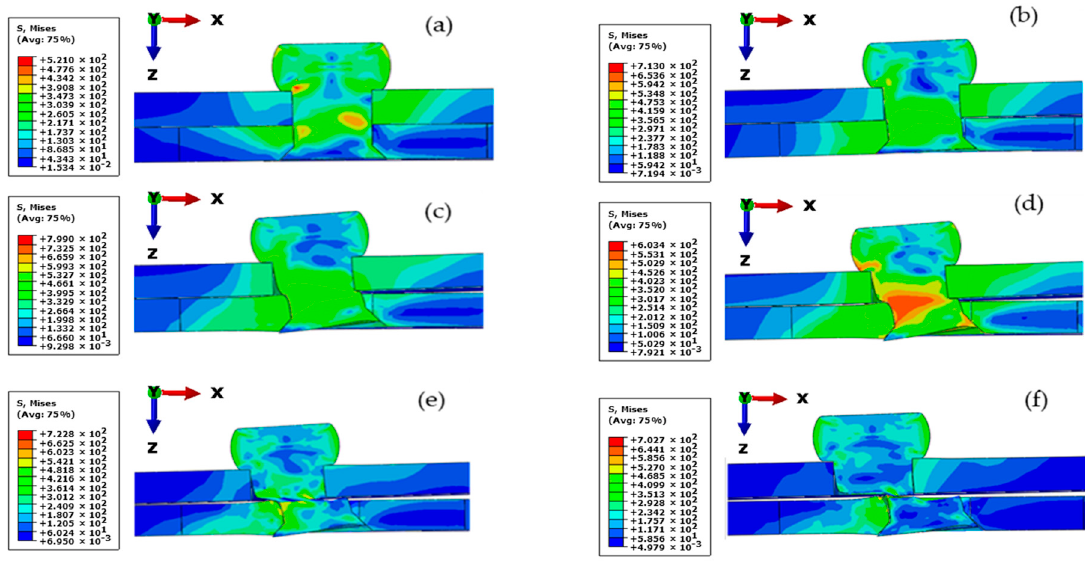
Figure 18. Shear failure process of rivet. (Unit: MPa). ( a ) Riveting completed. ( b ) Shear starting. ( c ) Deformation of rivet. ( d ) Significant stress concentration. ( e ) Rivet obvious deformation. ( f ) Shear fracture of rivet.